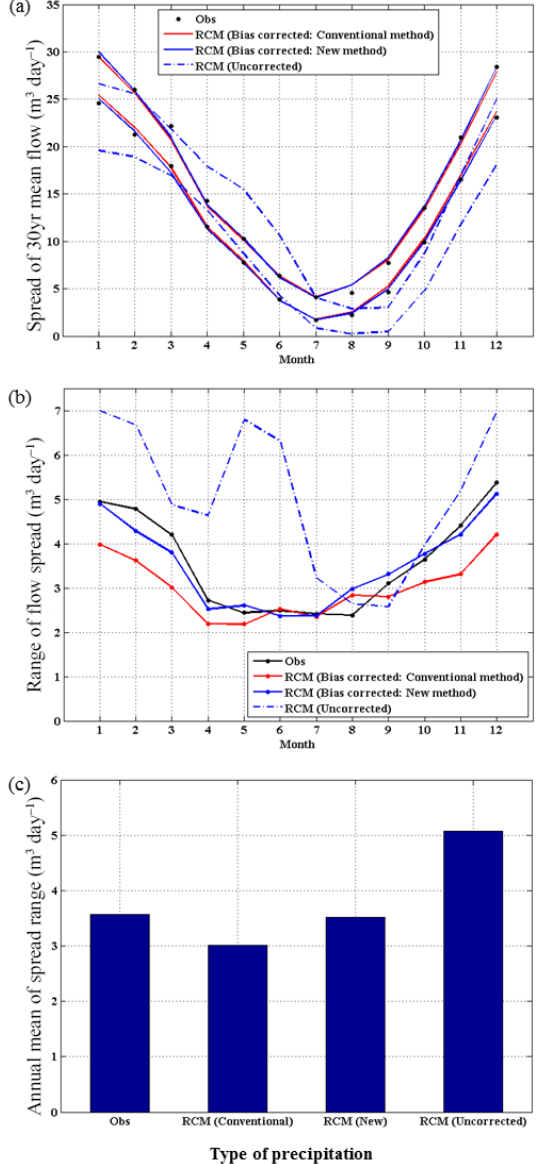
Figure 12. (a) The range of monthly mean flow simulated from the precipitation ensembles for the period 1961–1990 (5–95th per- centile spread); (b) the range of monthly spread; (c) annual average value of the